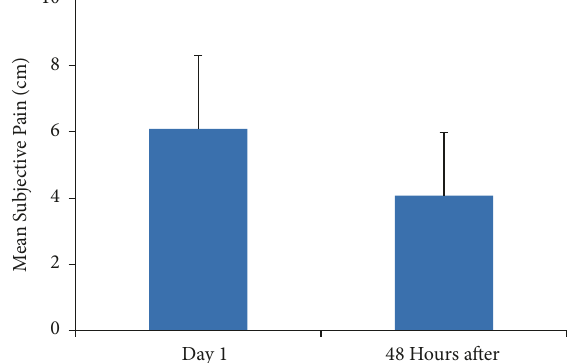
Figure 1: Participants flow diagram.